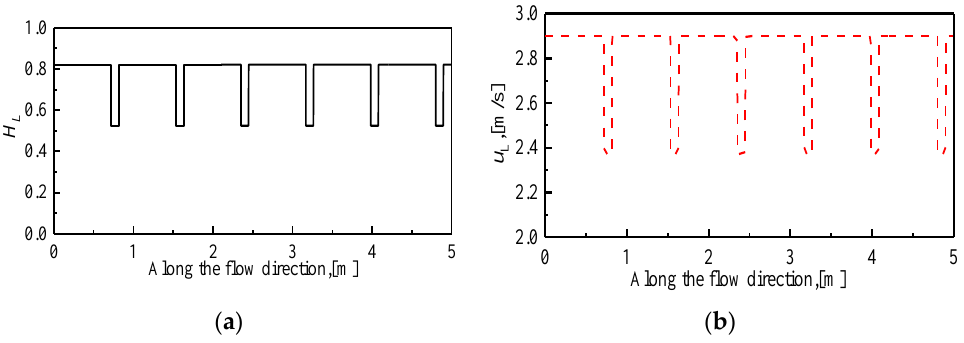
Figure 4. Distributions of liquid holdup and liquid velocity along the pipe for J L = 2.0 m/s, J g = 0.9 m/s, and WC = 50%. ( a ) Distribution of liquid holdup; ( b ) Distribution of liquid velocity.